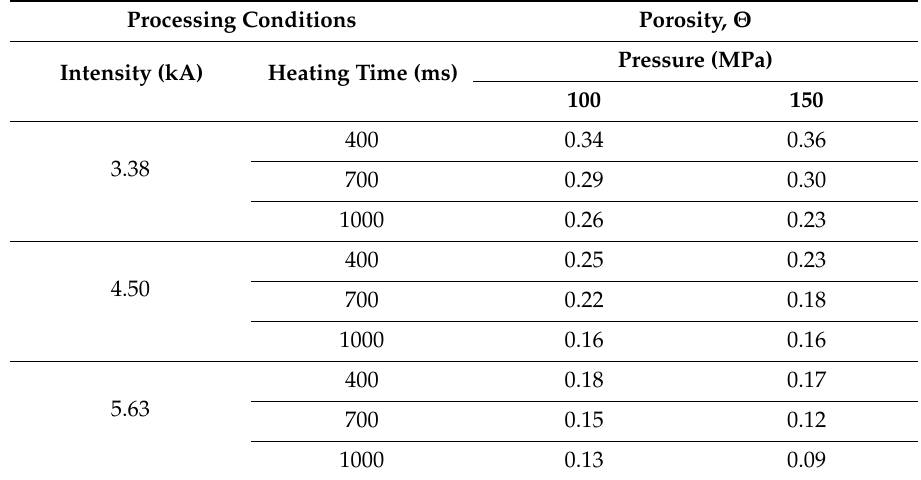
Table 1. Porosities ( Θ ) for di ff erent electrical consolidation conditions for 9 mm in diameter compacts. Processing